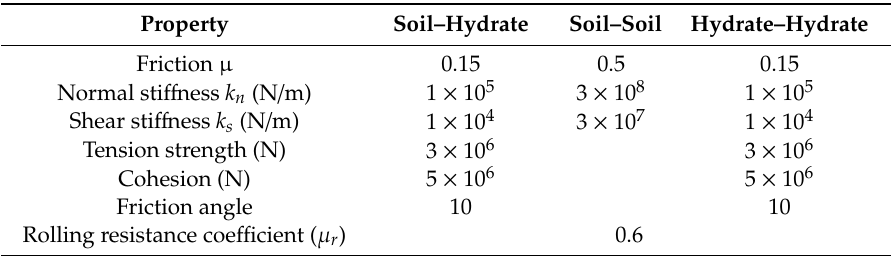
Table 2. Mechanical parameters of contacts in the simulation.